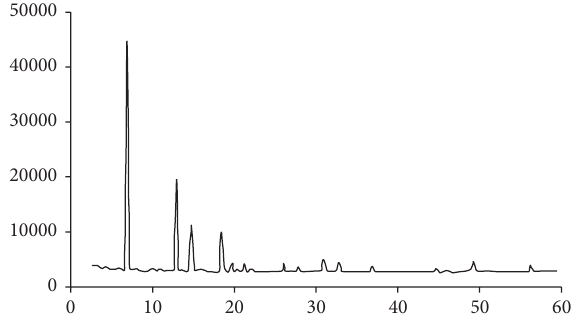
Figure 11: XRD diagram after adding